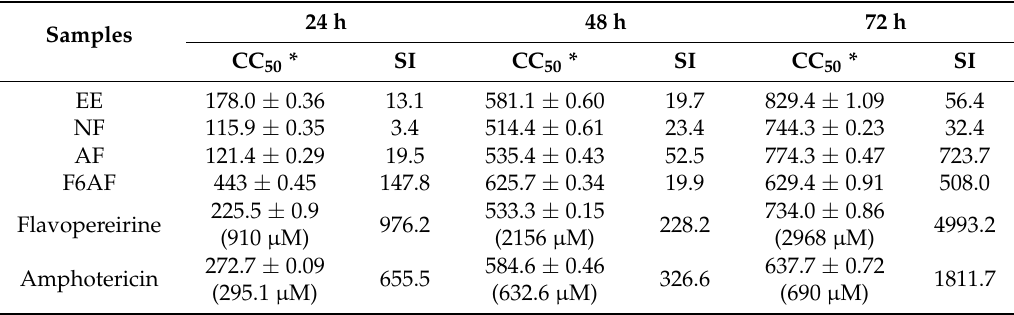
Table 3. Cytotoxicity (CC 50 ) and selective index (SI) of G.